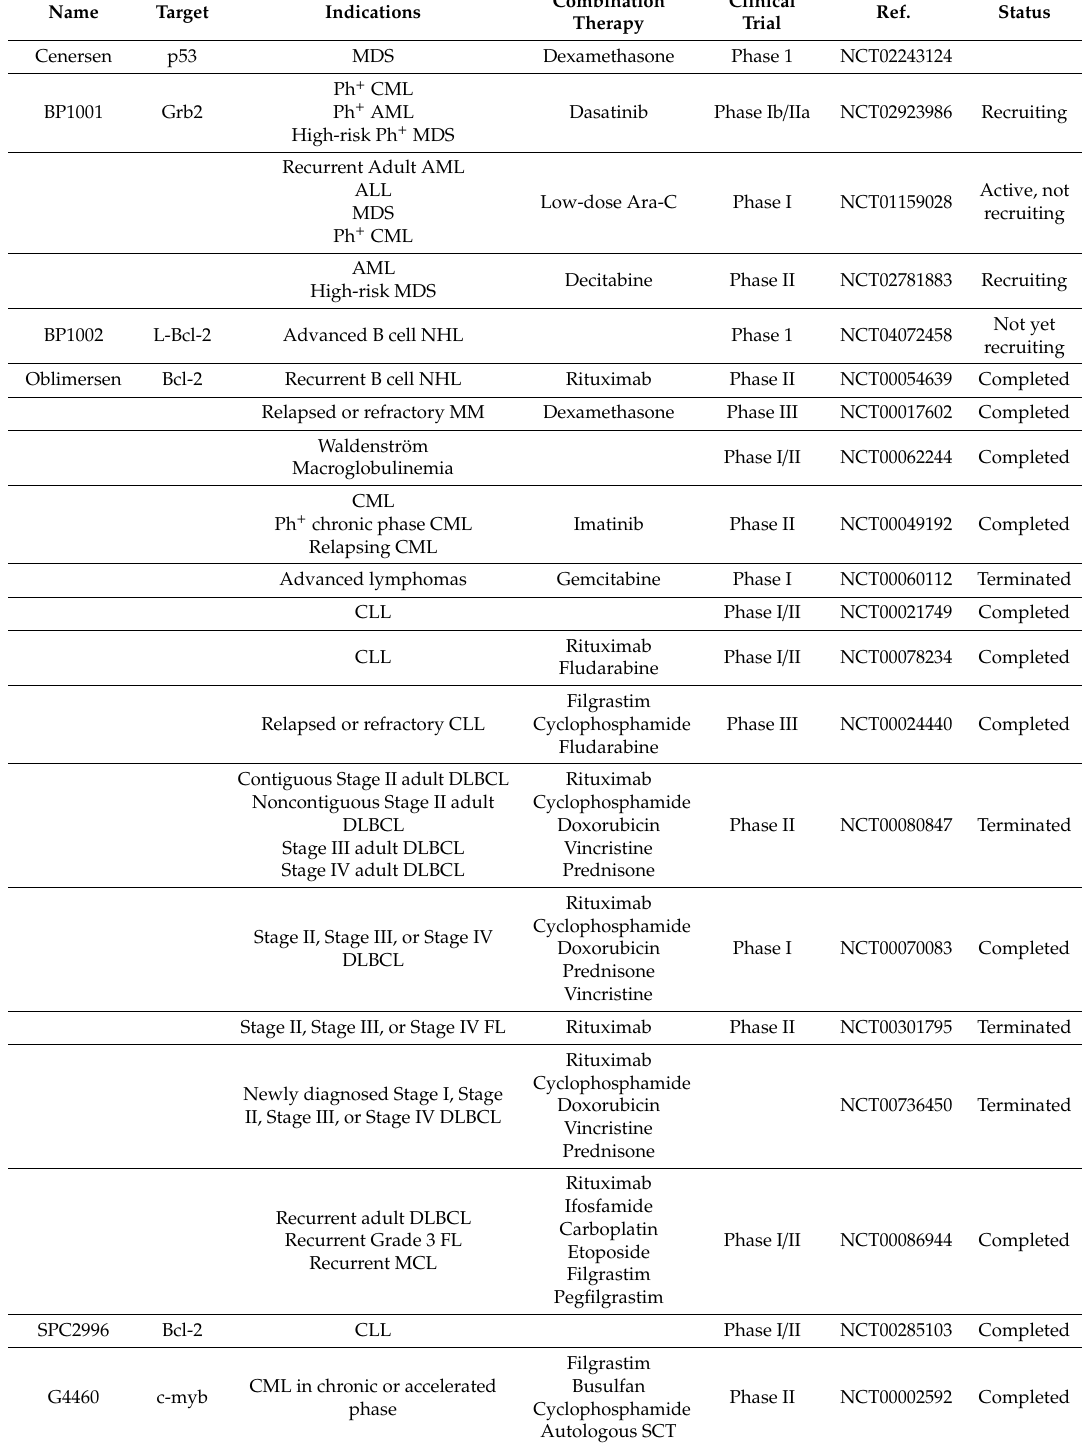
Table 1. Therapeutic antisense oligonucleotides (ASOs) for hematological